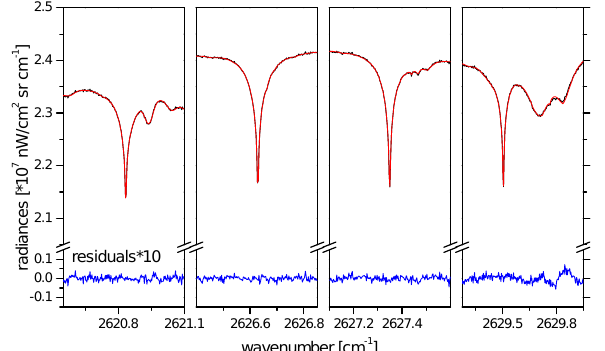
Figure 2. The four spectral microwindows used for the ground- based FTIR retrieval. Shown is an example of a typical measure- ment at Karlsruhe (04 June 2010, 07:36UT, solar elevation 38.15 ◦ ). Fig. 2. The four spectral microwindows used for the ground-based (26 October 2010, 08:44UT, solar elevation: 18.1 ◦ ). Black: mea- FTIR retrieval. Shown is an example for a typical measurement at sured spectrum, red: simulation and residuals (difference between Karlsruhe (04 June 2010, 7.36 UT, solar elevation 38.15 ◦ ). Black: measurement and simulation) multiplied by a factor of 10 (blue). measured spectrum, red: simulation and residuals (difference be- tween measurement and simulation) multiplied by a factor of 10 (blue).